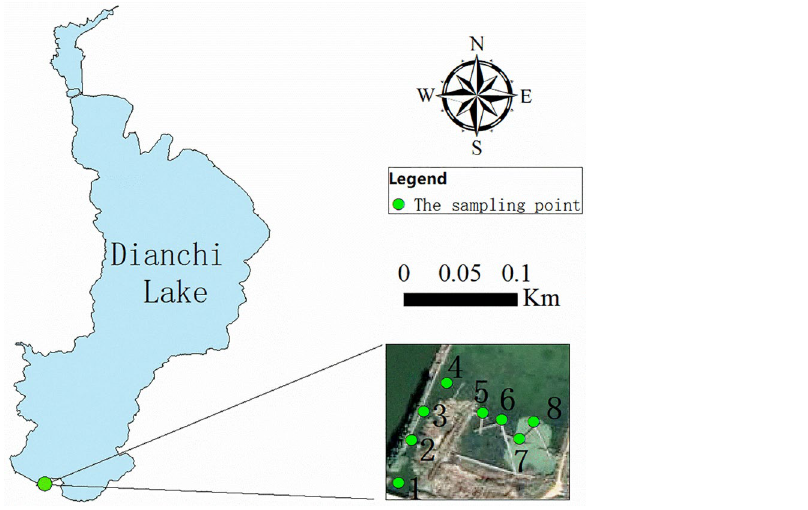
Figure 1. Distribution of sampling